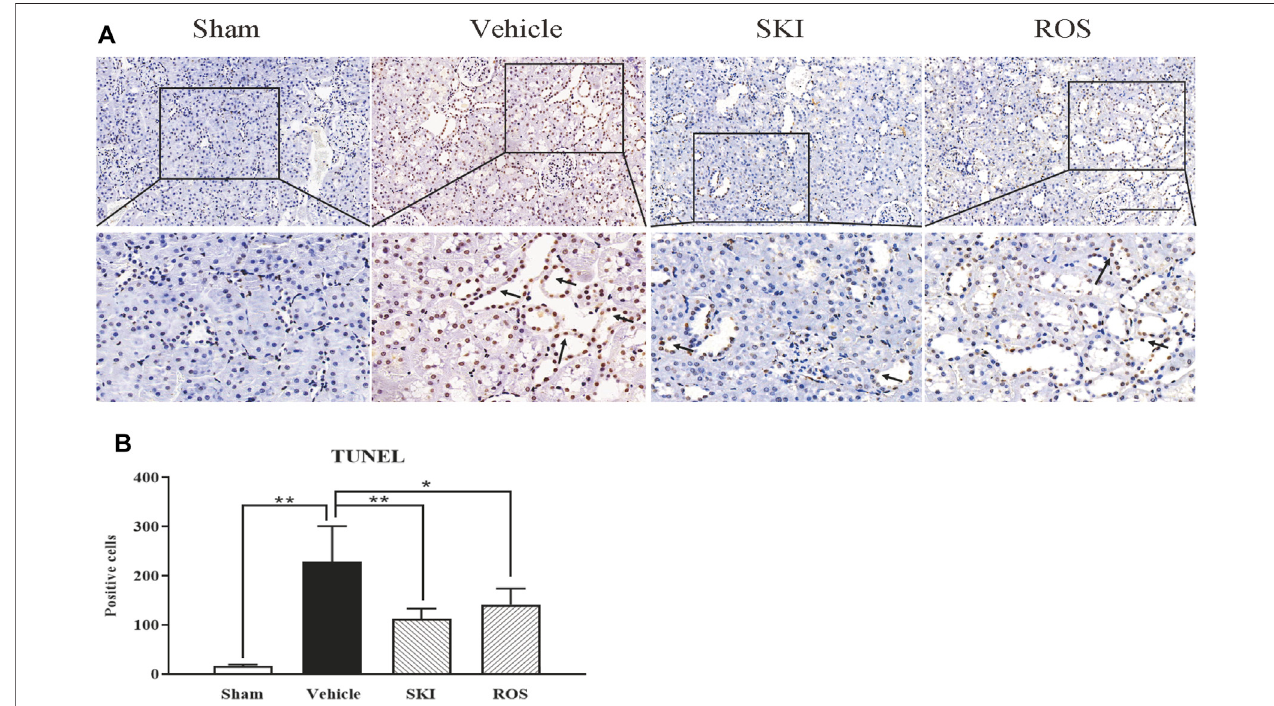
FIGURE 8 | The effects of SKI and ROS on TUNEL staining in vivo . (A) TUNEL staining in the kidney ( × 200); (B) The number of positively stained cells. Scale bar (cid:2) 100 μ m. Data are expressed as mean ± S.E. * p < 0.05, ** p < 0.01. Abbreviations: TUNEL, terminal deoxynucleotidyl transferase dUTP nick end labeling; ROS, rosiglitazone; SKI, Shenkang